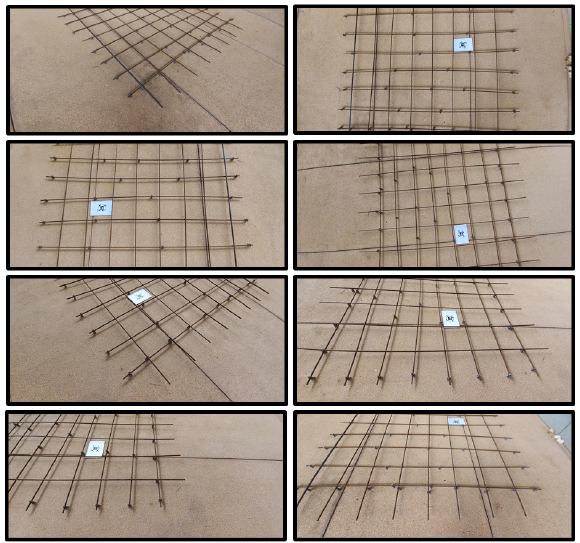
Figure 2. Rebar grid framework